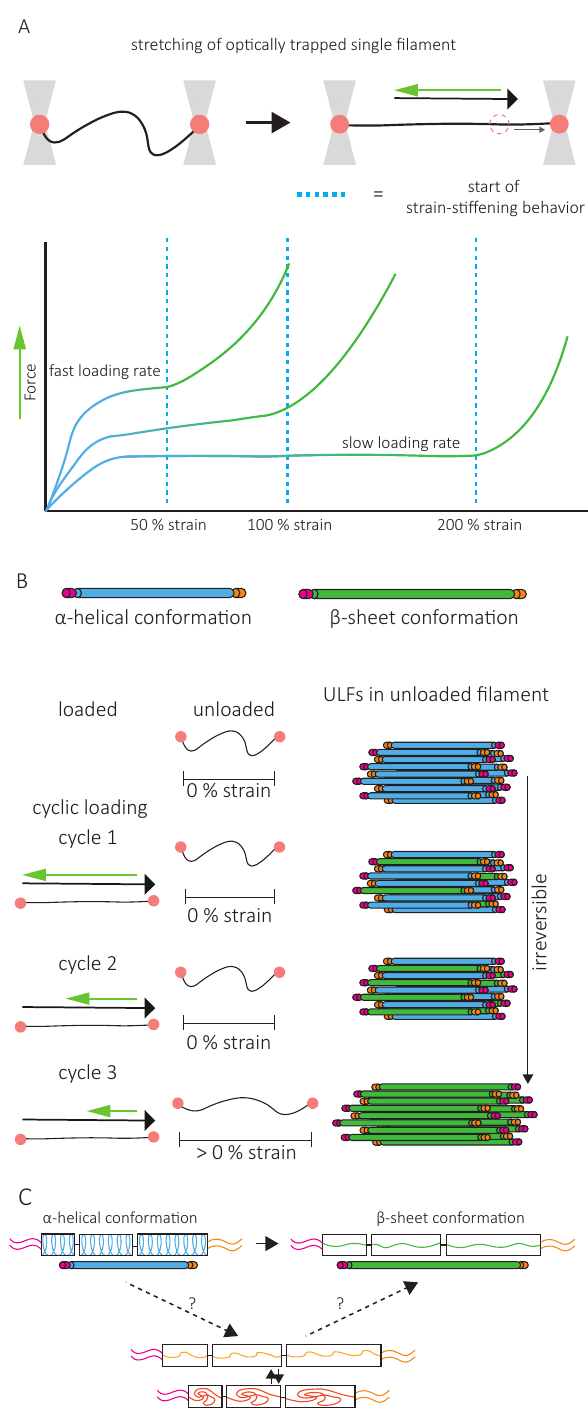
Figure 5. Single intermediate filament mechanics and underlying conformational changes. ( A ). Optical trap of a single intermediate filament and force–strain curves generated from stretching a single filament at different loading rates.